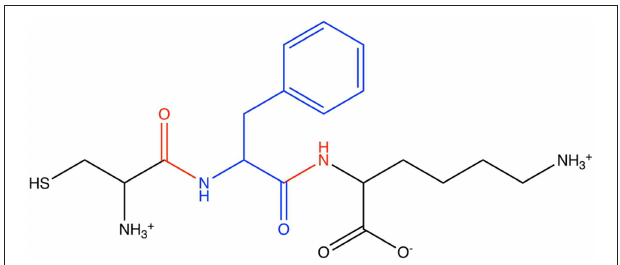
FIGURE 6 | Example of a fragment in the user-specified Athenaeum: the phenylalanine-centered tripeptide Cys-Phe-Lys, showing (blue) the core atoms of the phenylalamine fragment and (red) the overlap